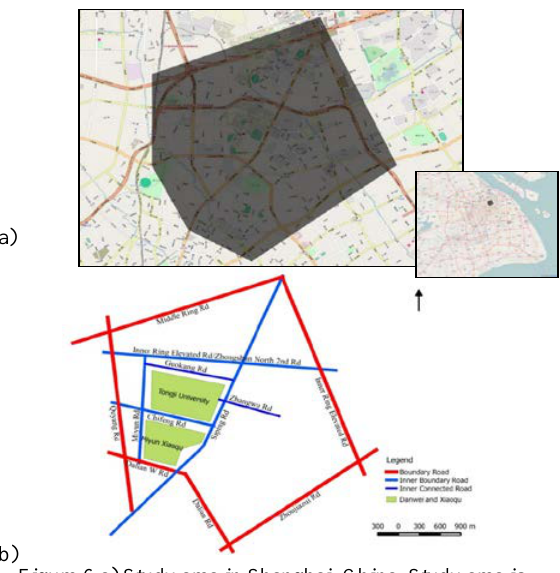
Figure 6 a) Study area in Shanghai, China. Study area is covered by a light grey shadow. Open Street Map (OSM)